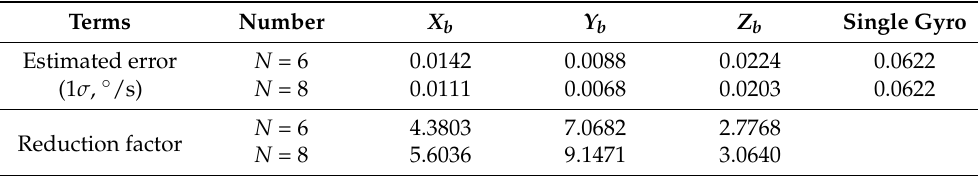
Figure 19. Sinusoidal results of the 8-gyro MIMU system for scheme 2. ( a ) The outputs of the gyros. ( b ) The estimated results of the MIMU. Table 5. The estimated errors of 6- and 8-gyro MIMU systems for scheme 1.